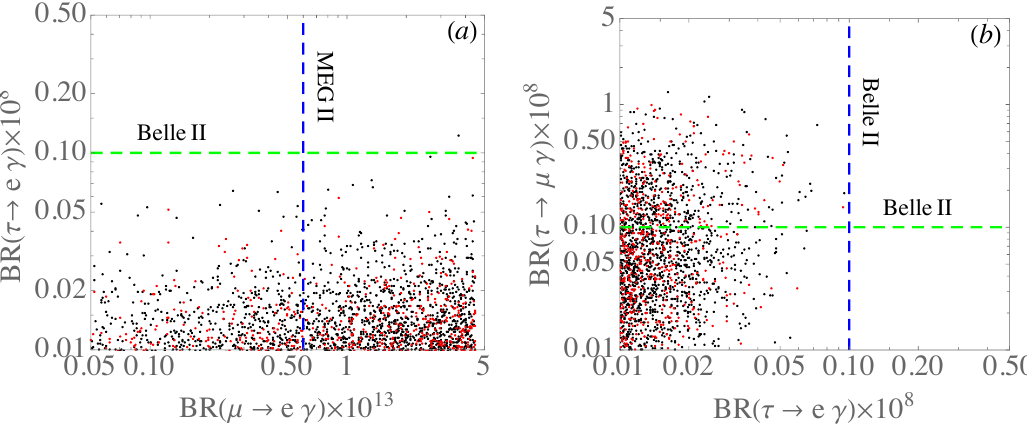
Figure 8 . Correlation of BR in LFV processes: (a) τ → eγ and µ → eγ , and (b) τ → µγ and τ → eγ . The black and red points denote the results of NO and IO, respectively.